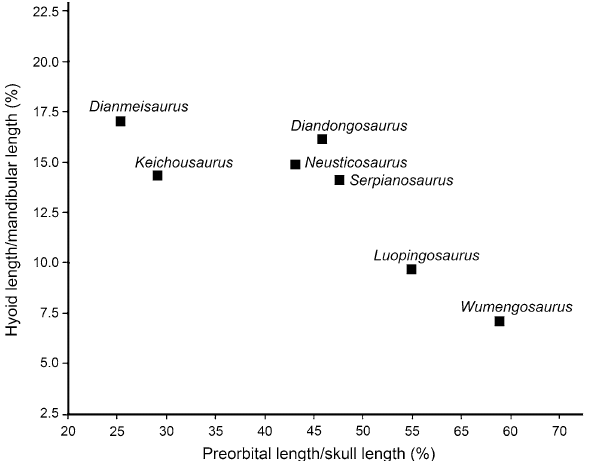
Figure 6. The ratios of preorbital length to skull length relative to those of hyoid length to mandibular length in